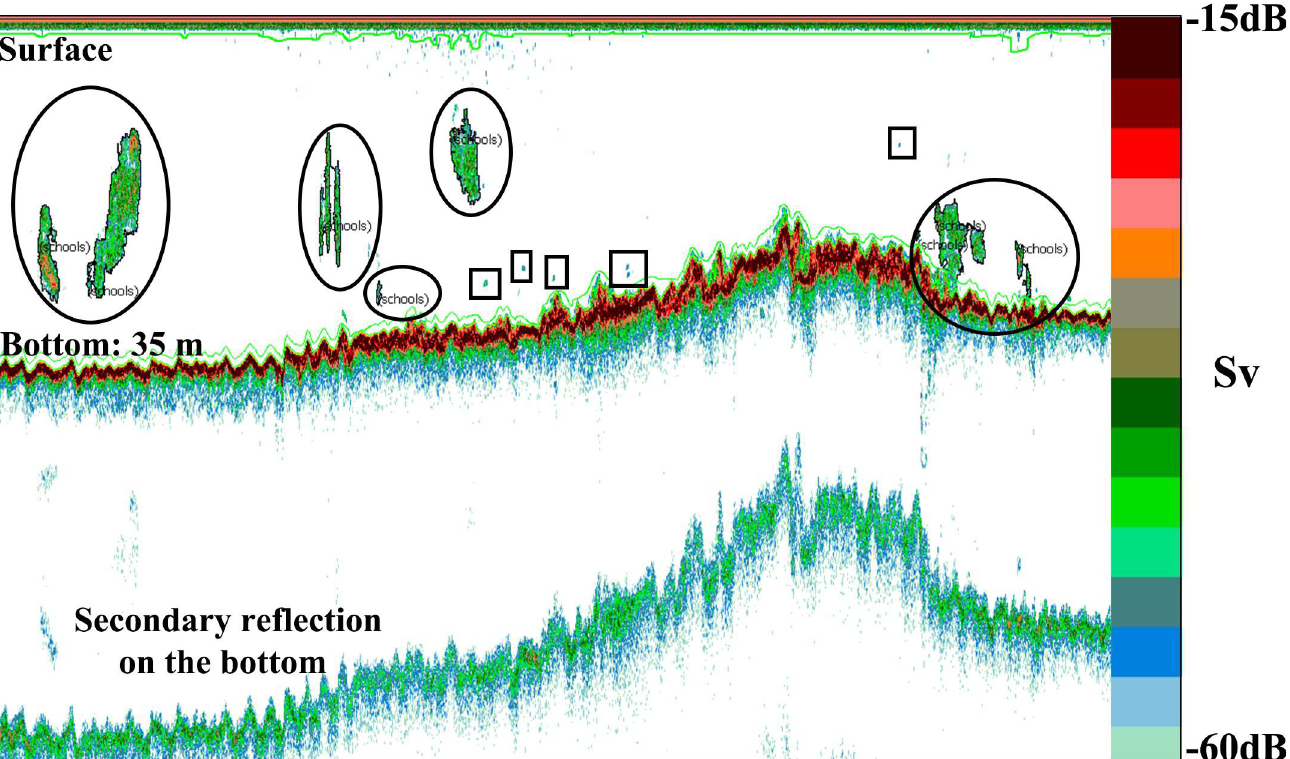
Fig 2. The echogram shows object fish schools and non-object fish schools. The circled area indicates the object fish school, and the square area indicates non— object fish school.